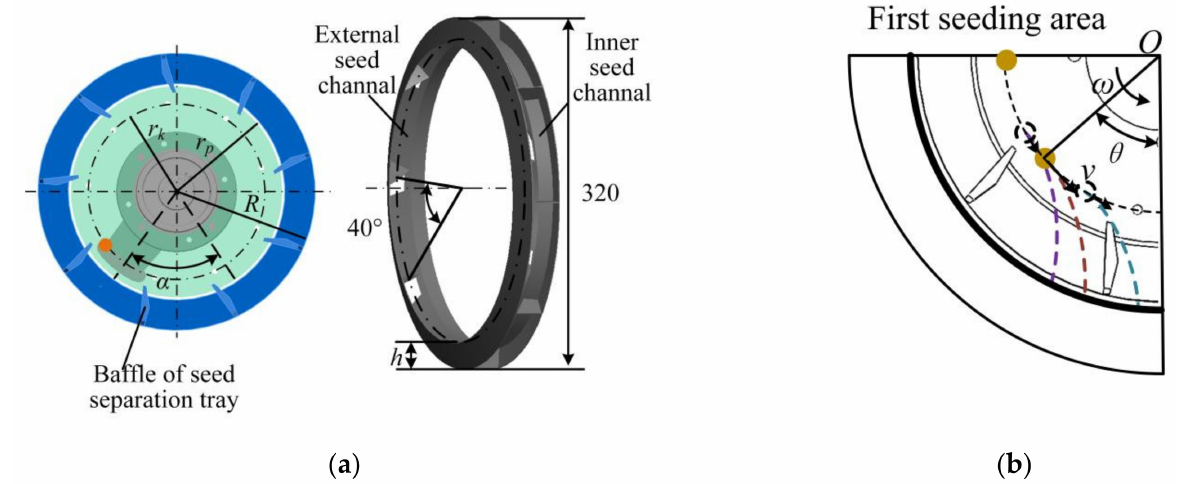
Figure 3. ( a ) Internal structural parameters of the dibbler; ( b ) seed-feeding trajectory at different chock-block installation angles.